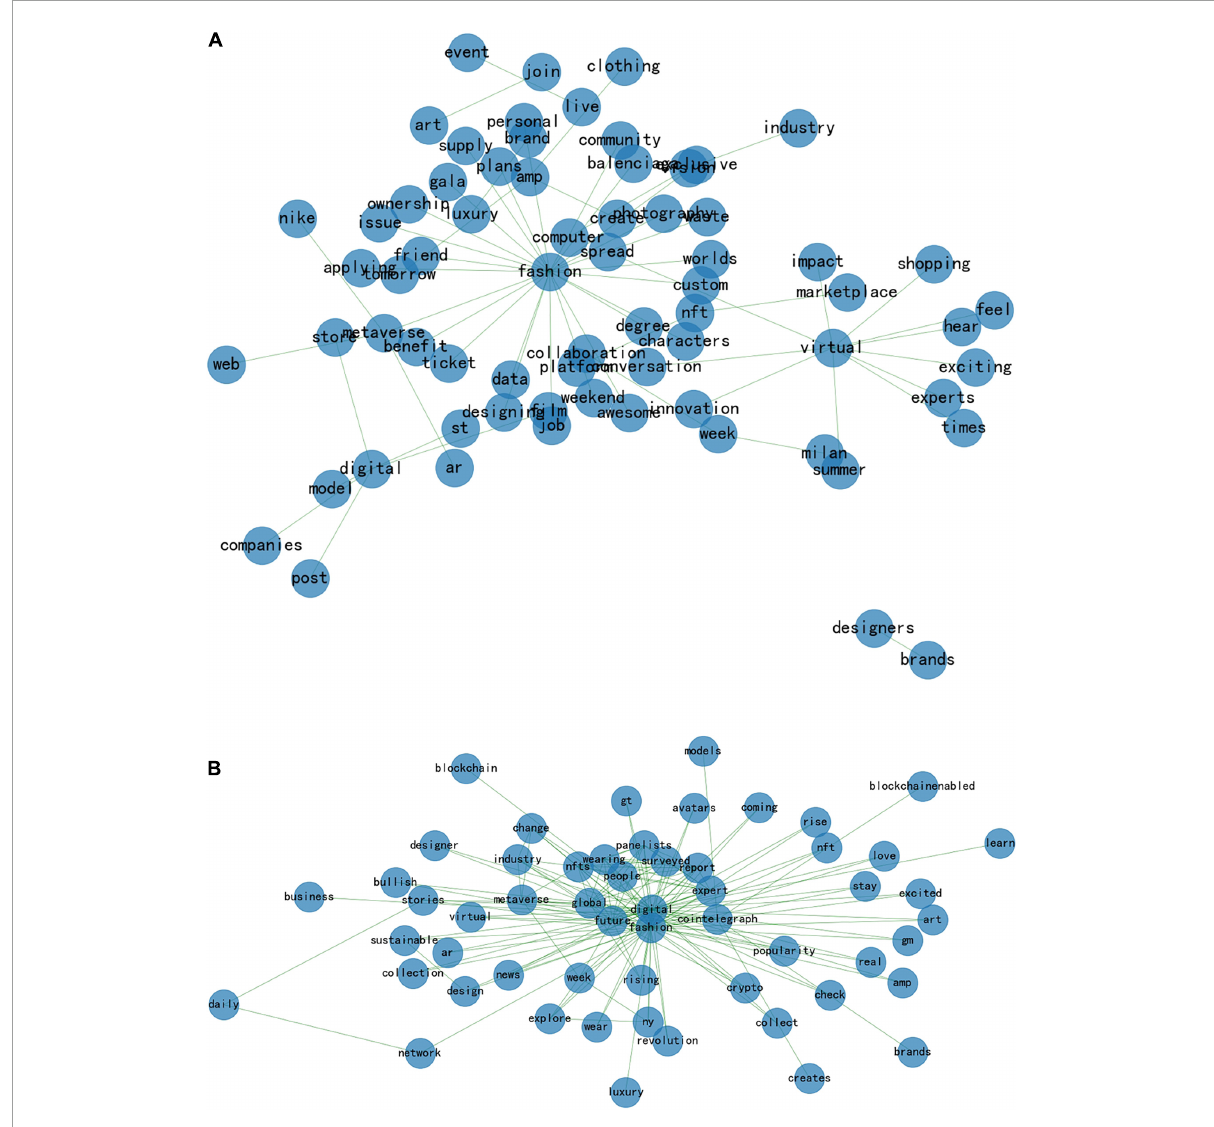
FIGURE6 (A) Clustering—network semantics. (B) Clustering—network